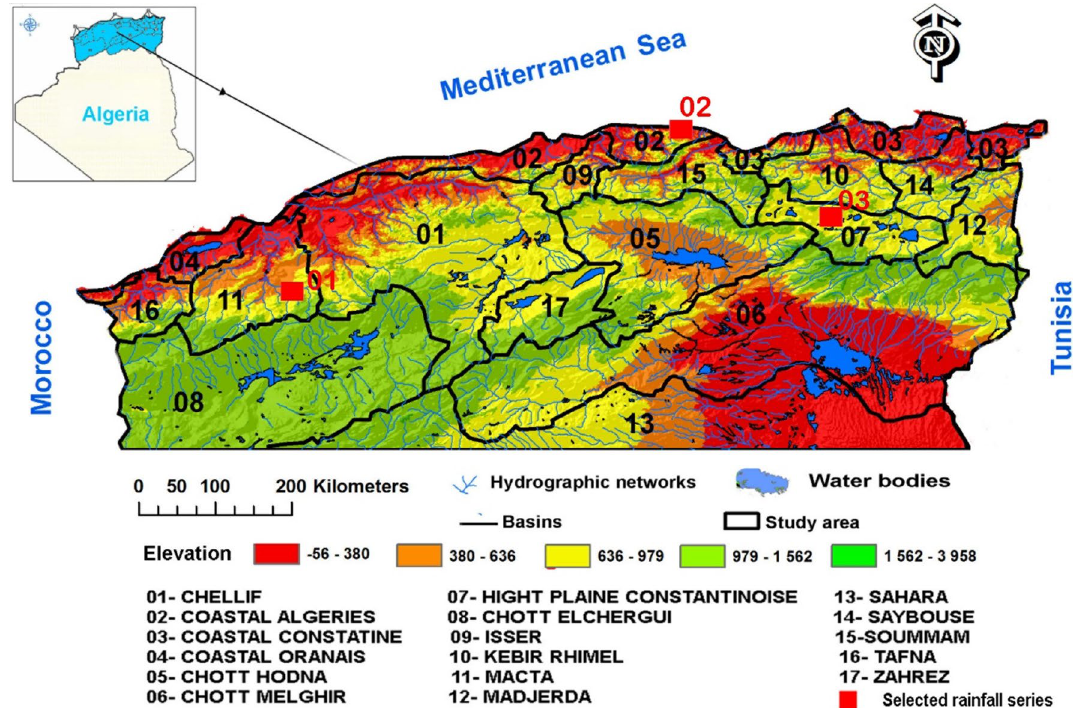
Fig. 1 Digital elevation model of Northern Algeria and the main selected rainfall stations used in this